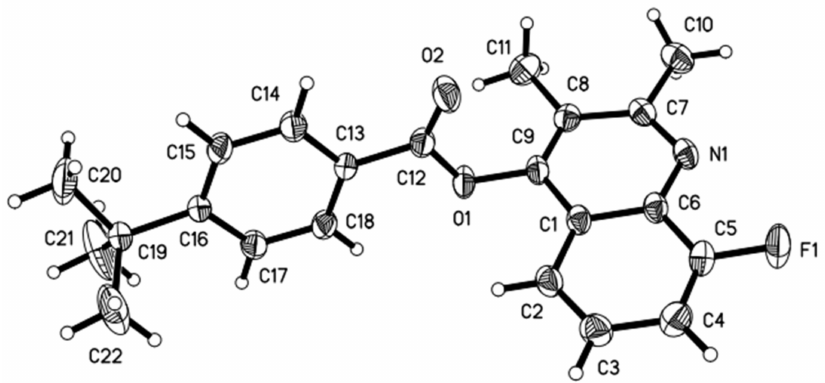
Figure 3. Molecular structure of the title compound 2b .